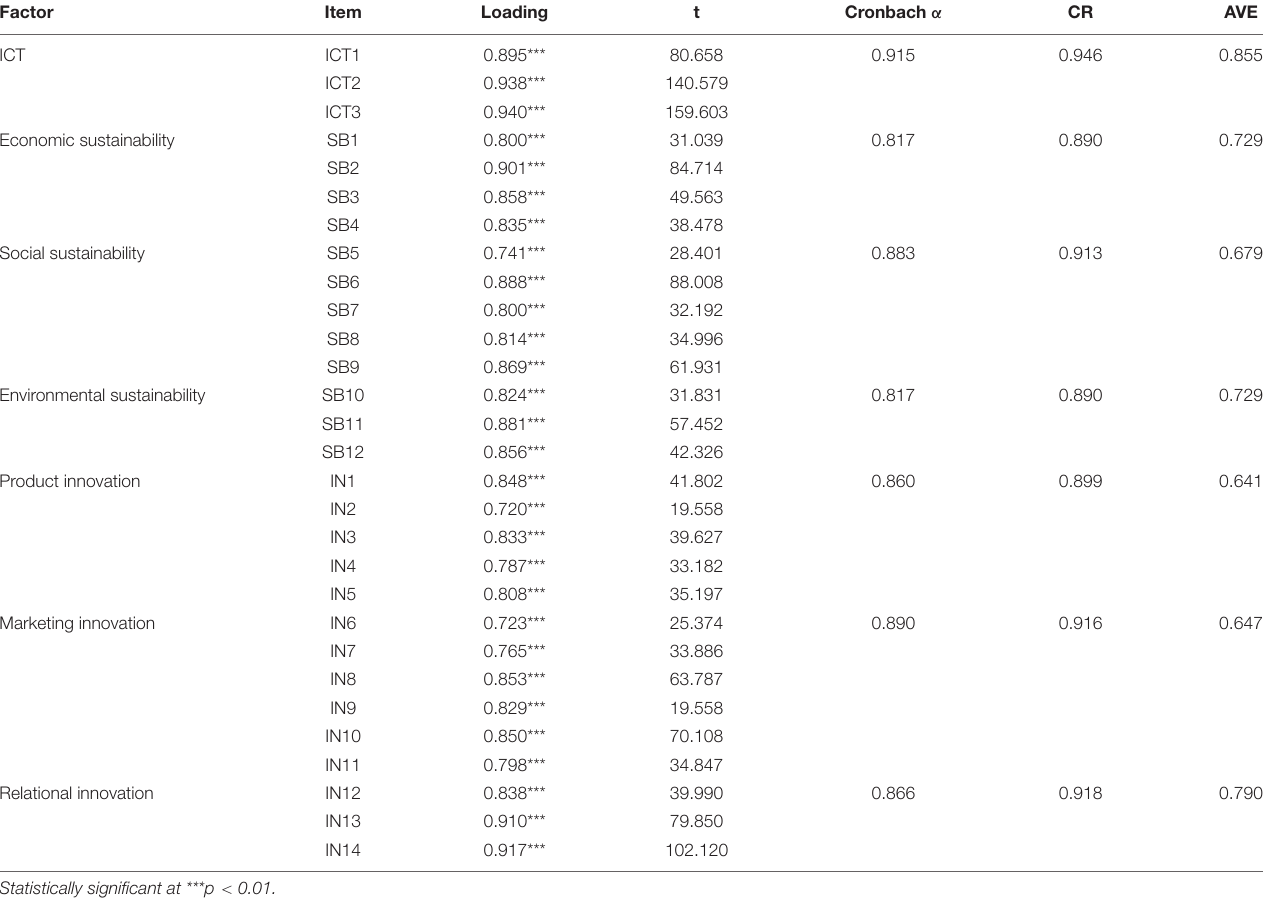
TABLE 2 | Measurement instrument of the structural model: Reliability and convergent validity. Factor